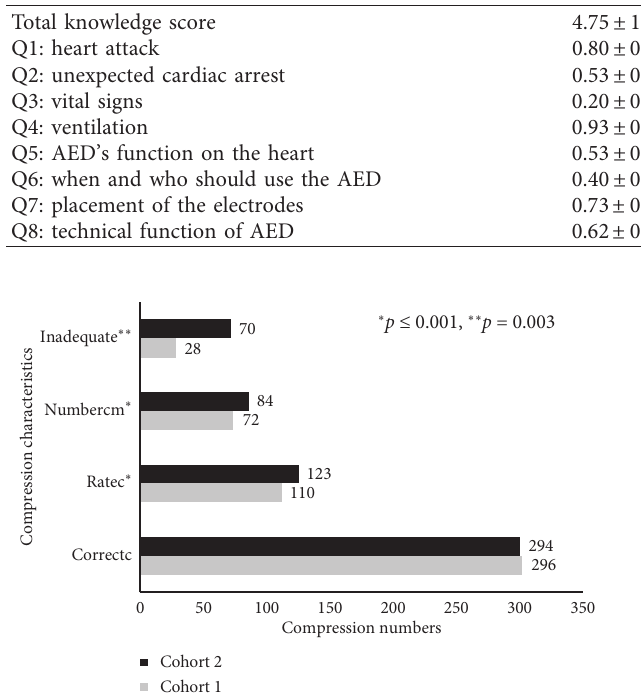
Figure 1: Comparison of compression parameters of the CPR test between the two